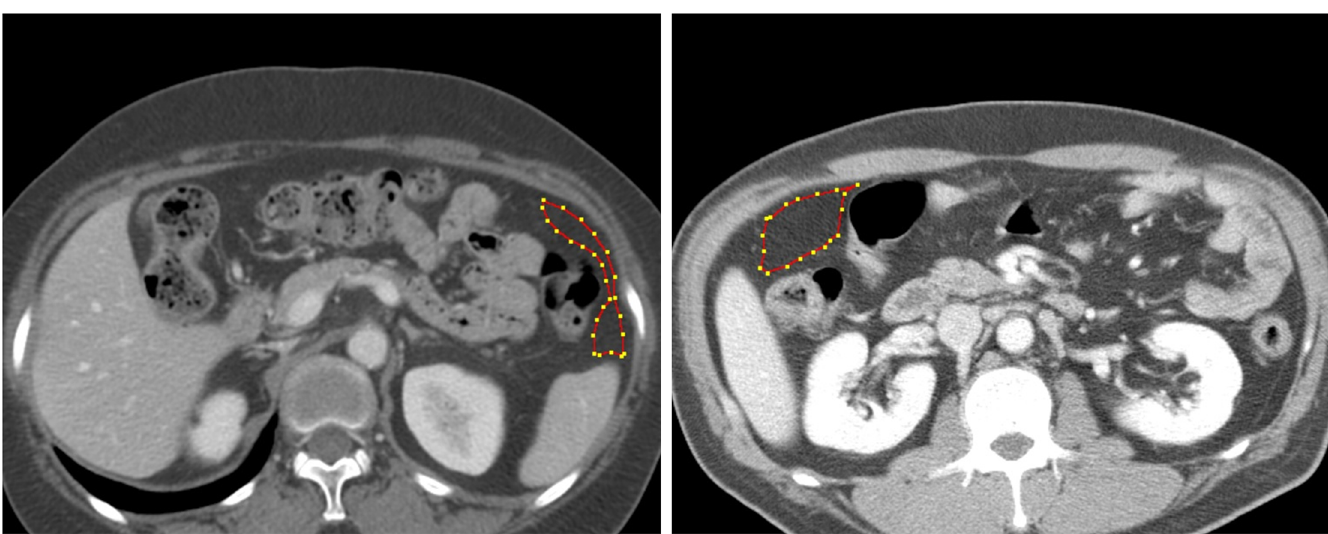
Fig 2. Region of interest (ROI) in texture analysis. 49-year-old male with T3N2 advanced gastric cancer (AGC) without seeding (a) showed entropy of 7.05 within the ROI. 59-year-old female with T3N2 AGC with occult seeding (b) showed entropy of 7.70, which was higher than the optimal cut-off value ( > 7.141) obtained from the receiver operating characteristic (ROC)